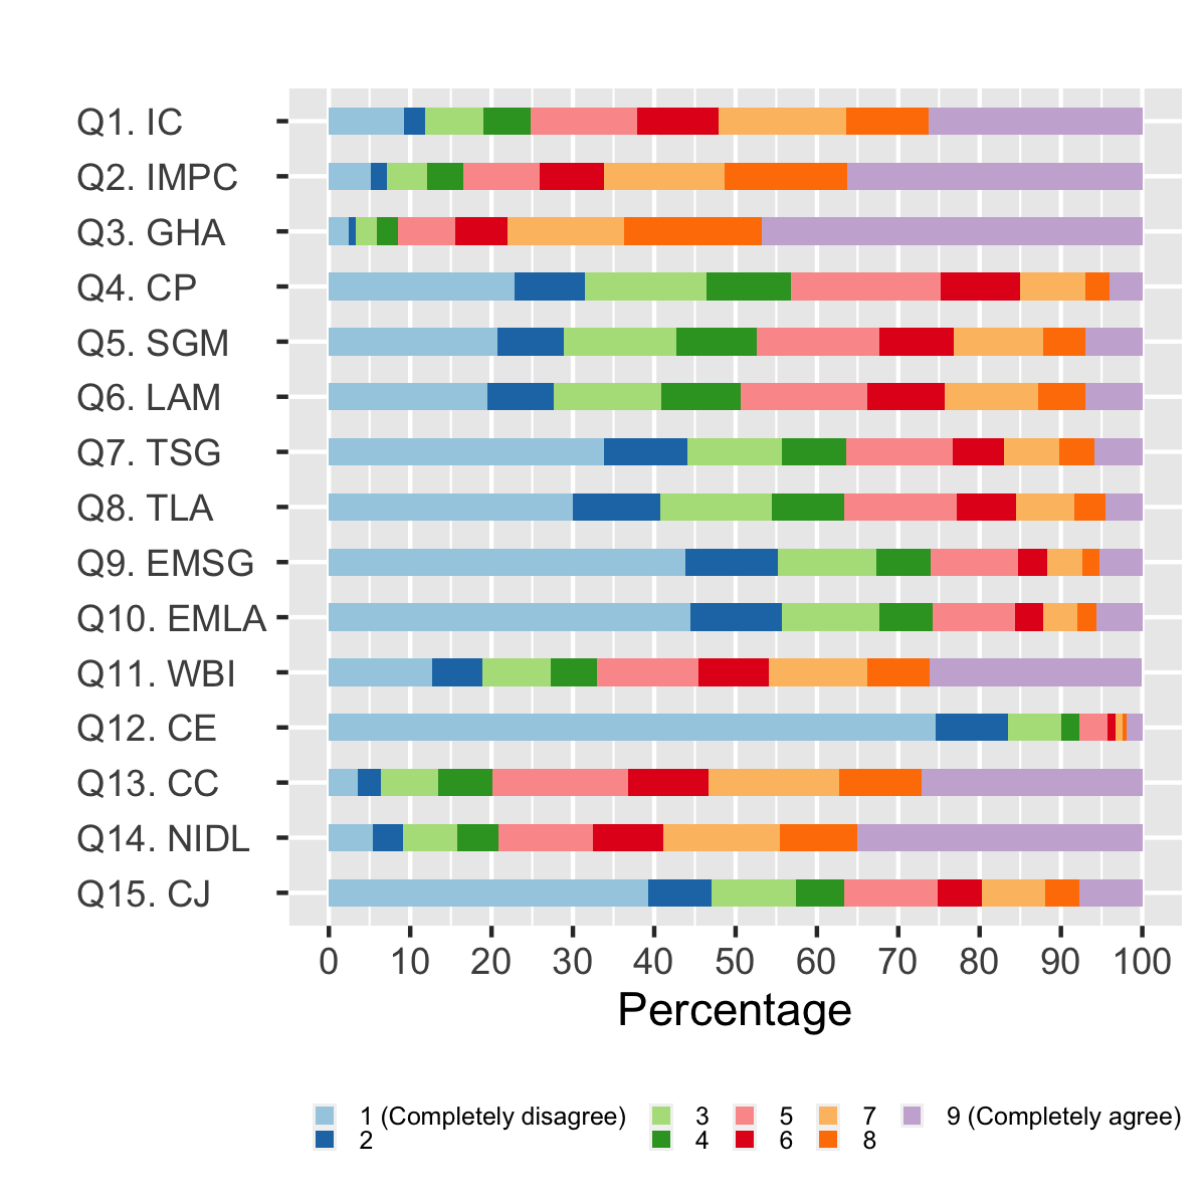
Figure 4. Respondents' answers to the questions addressing confidence, understanding, trust, and concerns. CC: The COVD-19 situation concerns me significantly; CE: I believe the crisis caused by COVID-19 will eventually resolve with little consequence for my country’s economy; CJ: I believe the crisis caused by COVID-19 will eventually resolve with little consequence for my job/business; CP: I think the country I am responding from is well prepared for COVID-19; EMLA: I think the measures taken by the local authorities in the city/town/village/etc against COVID-19 are excessive; EMSG: I think the measures taken by the country government against COVID-19 are excessive; GHA: I understand the guidance from health care authorities related to COVID-19; IC: I feel informed about COVID-19; IMPC: I feel informed about measures to prevent infection with COVID-19; LAM: I think that all possible local authority measures to fight COVID-19 are being taken in my city/town/village/etc; NIDL: The COVID-19 situation is negatively impacting my day-to-day life; Q: question; SGM: I think all possible government measures to fight COVID-19 are being taken in my country; TLA: I trust the local authorities in the city/town/village/etc I am responding from; TSG: I trust the government in the country I am responding from; WBI: I am worried about becoming infected with COVID-19 no matter how much I take care of